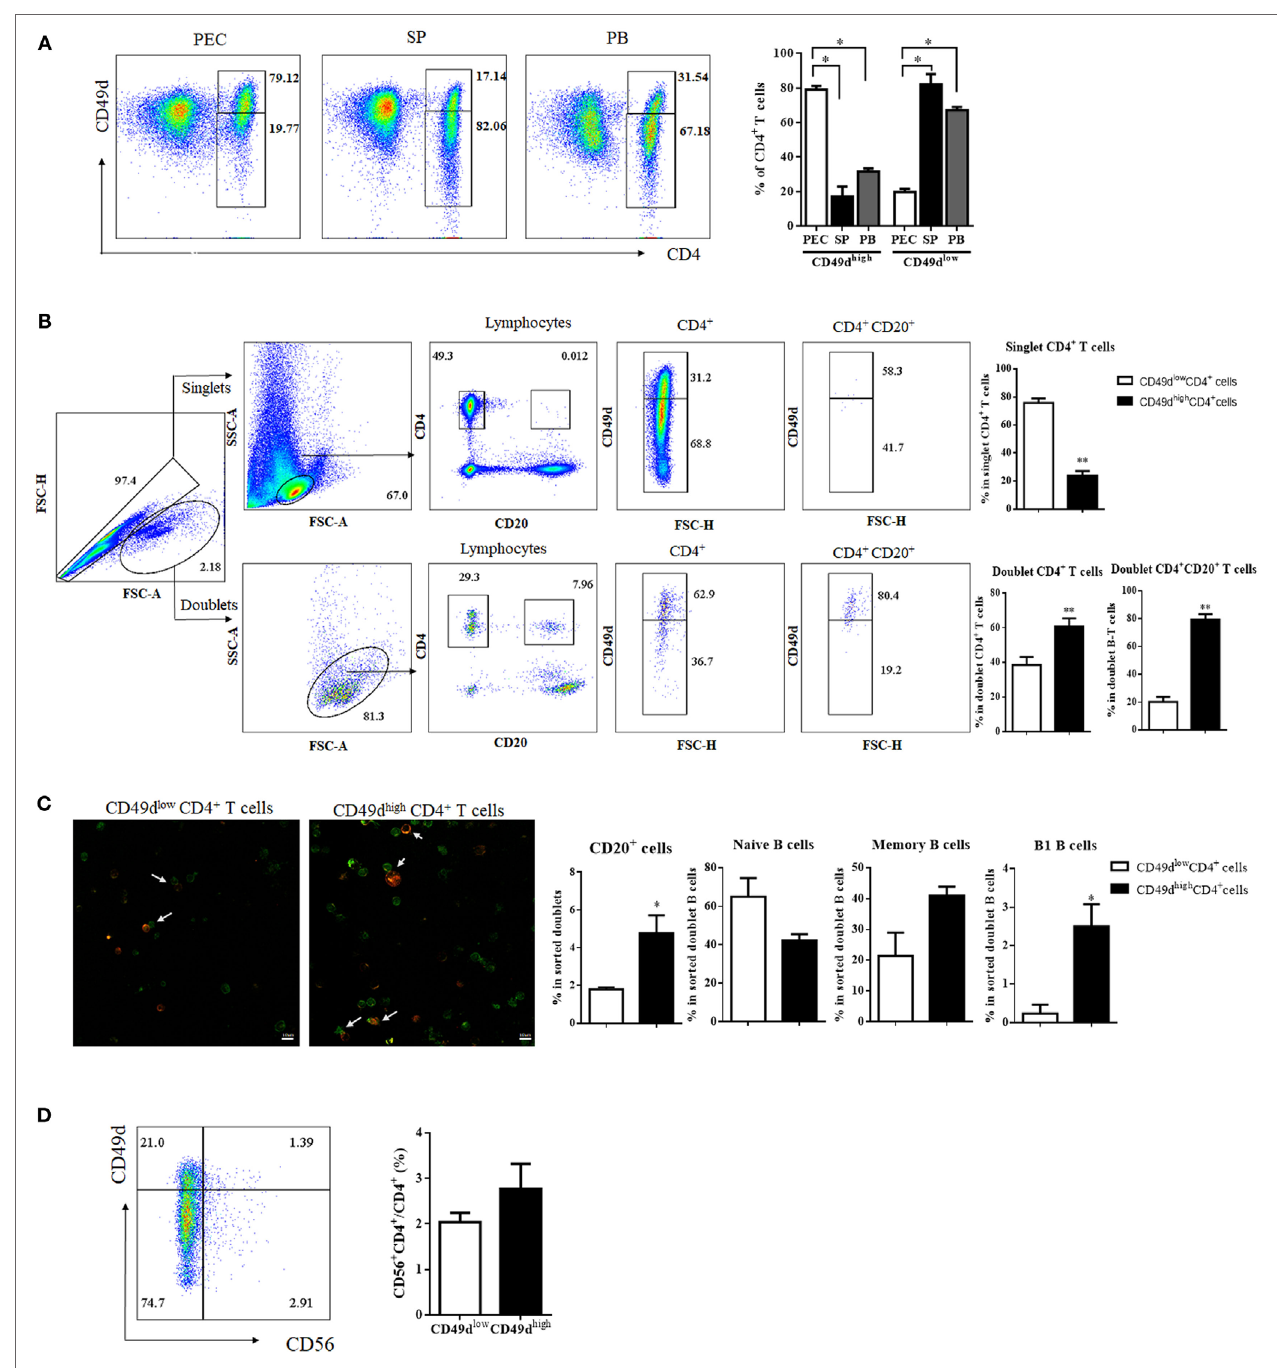
FigUre 1 | CD49d high CD4 + T cells were more prevalent in the human PEC than in the SP or PB. (a) Flow cytometric plots showing expression of CD4 and CD49d (integrin α 4) in cells from the PEC, SP, and PB. Values in diagrams indicate proportions of the gated population (left panel). Proportions of CD49d high CD4 + and CD49d low CD4 + T cells among CD4 + T cells in the PEC (white), SP (black), and blood (gray) (right panel). (B) For analysis of doublet CD4 + T cells, singlets and doublets were gated based on FSC-A and FSC-H. After gating for CD4 + CD20 − or CD4 + CD20 + , each population was examined for CD49d expression. Values in diagrams indicate proportions of the gated population. Proportions of CD49d high CD4 + (black) and CD49d low CD4 + T cells (white) in the singlet CD4 + , doublet CD4 + , and doublet CD4 + CD20 + cells (right panel). (c) Immunofluorescence images of PB B–T conjugates (green: CD4, red: CD20, magnification 200 × ). White arrows indicate conjugate of B and T cells (left panel). Proportions of total CD20 + B cells, CD20 + CD27 − CD43 − naïve B cells, CD20 + CD27 + CD43 − memory B cells, and CD20 + CD27 + CD43 + B-1 cells in CD49d high CD4 + (black) and CD49d low CD4 + T cell populations (white) (right panel). (D) To check for the presence of NKT cells in CD49d high CD4 + and CD49d low CD4 + T cells, CD4 + T cells were examined for the expression of CD56 as well as CD49d. Proportions of CD56 + NKT cells among CD49d high CD4 + (white) and CD49d low CD4 + T cells (black). The data are expressed as the mean ± SEM ( n = 4–10 donors per each group). * P < 0.05, ** P < 0.01; Student’s t -test. Abbreviations: PEC, peritoneal cavity; SP, spleen; PB, peripheral blood.